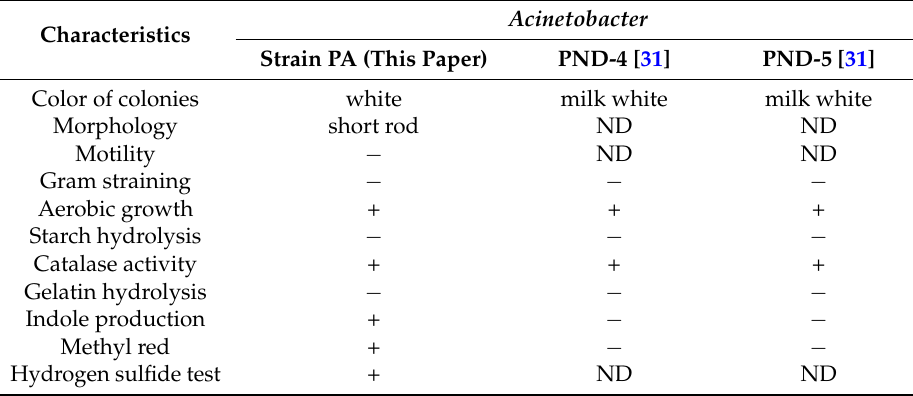
Table 1. Morphological and biochemical characteristics among Acinetobacter strains.